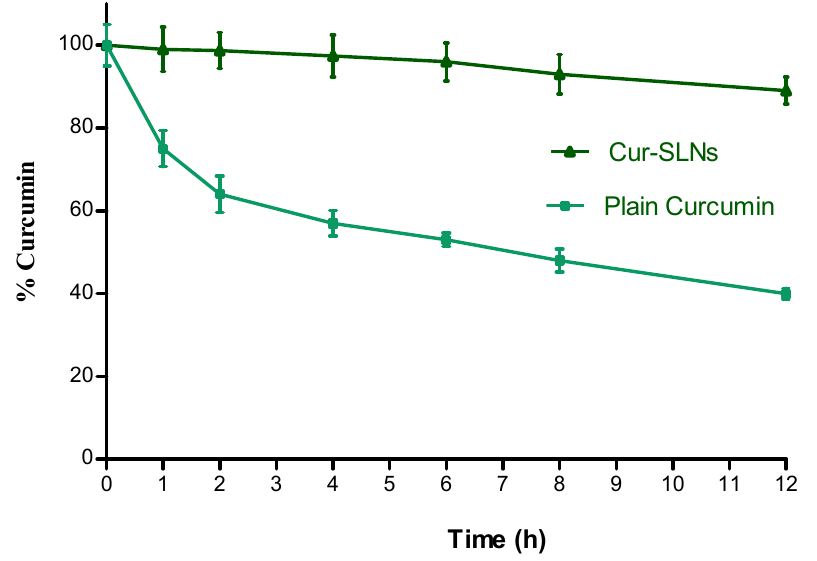
Figure 6. Stability of plain curcumin and Cur-SLNs in PBS (pH 7.4) at 37 °C. Data as mean ± SD, n = 3.